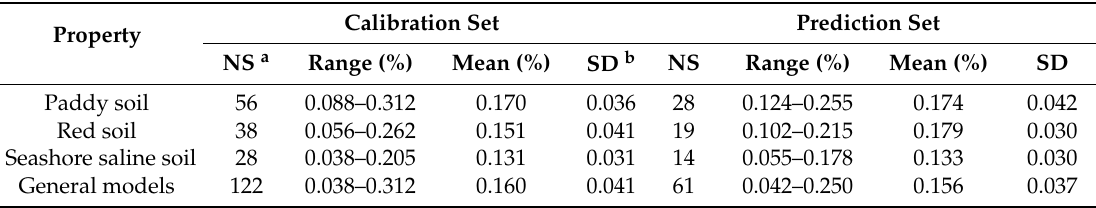
Table 2. Statistics of reference values of total nitrogen (TN) in the local models and general